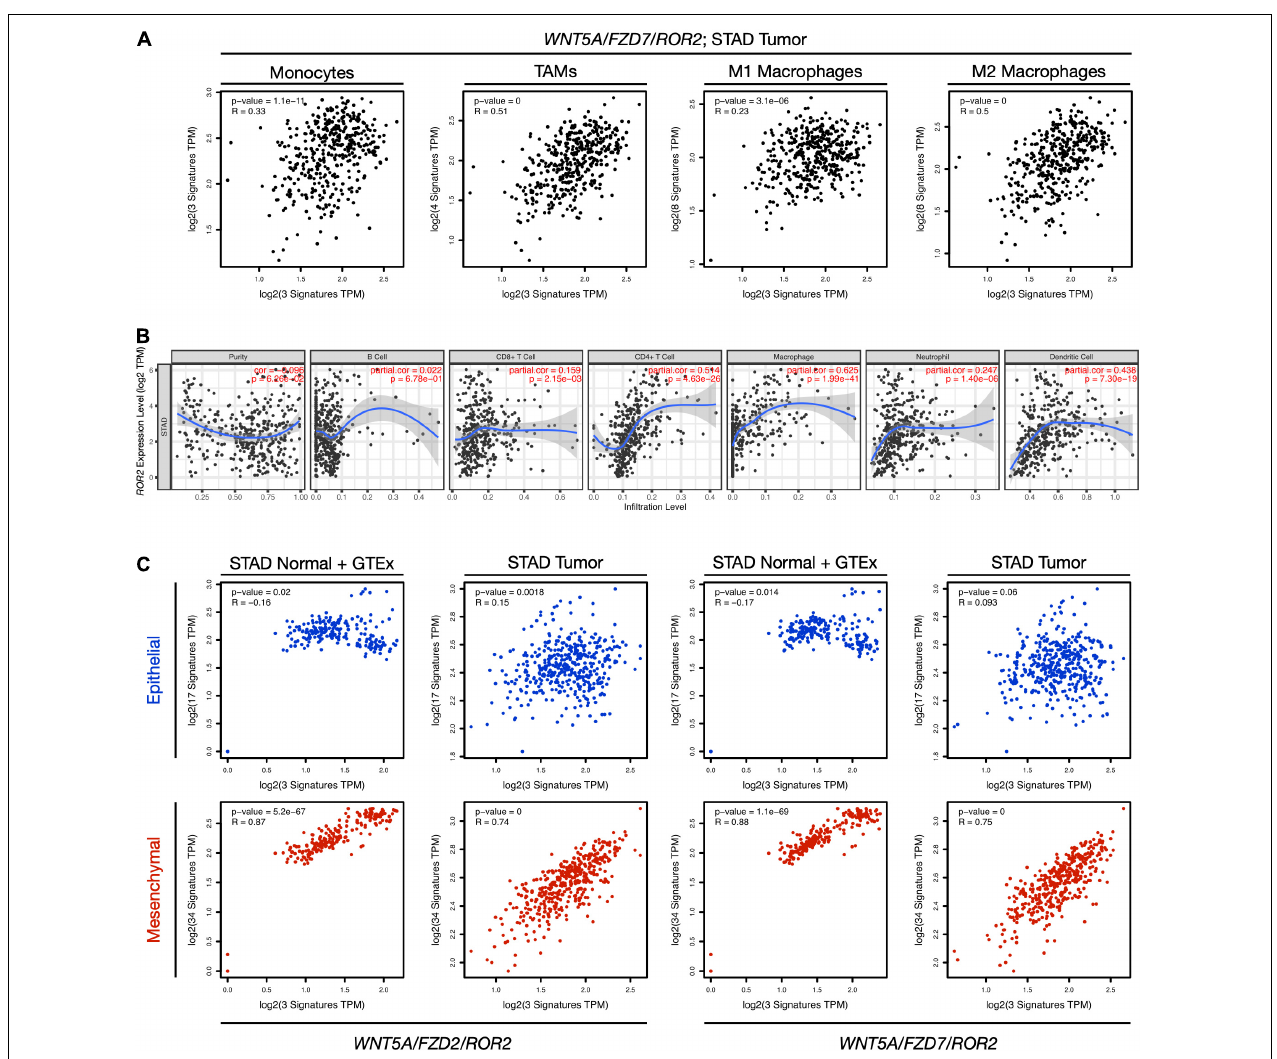
FIGURE 3 | Correlation between gene expression, immune cell markers, and EMT. (A) The correlation between the WNT5A / FZD7 / ROR2 signature and signatures of monocytes, tumor-associated macrophages (TAMs), M1 macrophages, and M2 macrophages for the STAD Tumor dataset was evaluated using the “Gene Signature” comparison option in GEPIA (Correlation Analysis). The Spearman correlation coefficients and p -values are indicated in each plot. The markers used for the analysis are listed in Supplementary Table 1 , and a full comparison including all Wnt signatures and both “STAD Normal + GTEx data” and “STAD Tumor data” is presented in Supplementary Table 3 . (B) Correlation between ROR2 gene expression and immune cell infiltration. The analysis was performed using TIMER, adjusting by tumor purity. See Supplementary Figure 4 for a panel including WNT5A , FZD2, and FZD7 . (C) Correlation between the indicated non-canonical Wnt signatures and gene signatures corresponding to an epithelial (blue) or mesenchymal (red) transcriptional program. Both “STAD Normal + GTEx data” and “STAD Tumor data” are included in the analysis. See main text for details. TPM, transcripts per